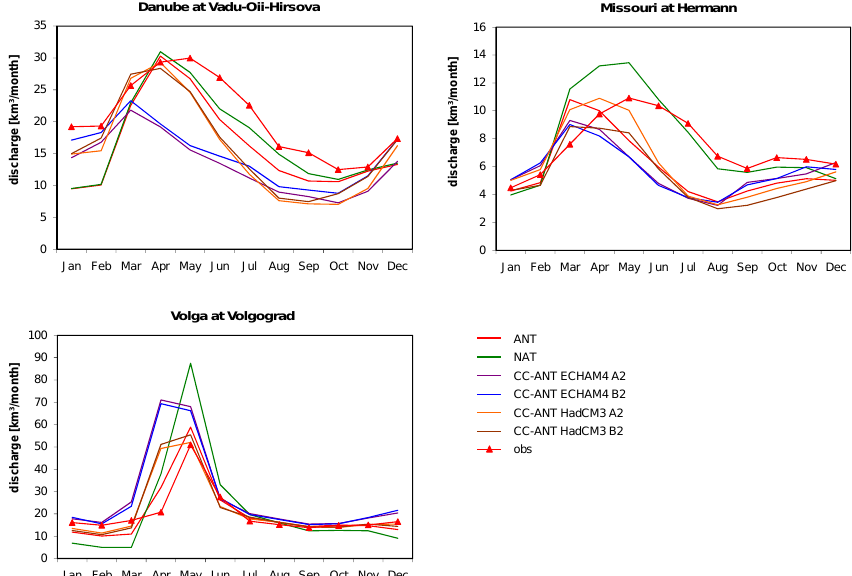
Fig. 7. Long-term average monthly discharge at three observation stations under anthropogenically altered and naturalized conditions for 1961–1990, and under anthropogenically altered conditions for 2041–2070 according to four climate change scenarios. Observation